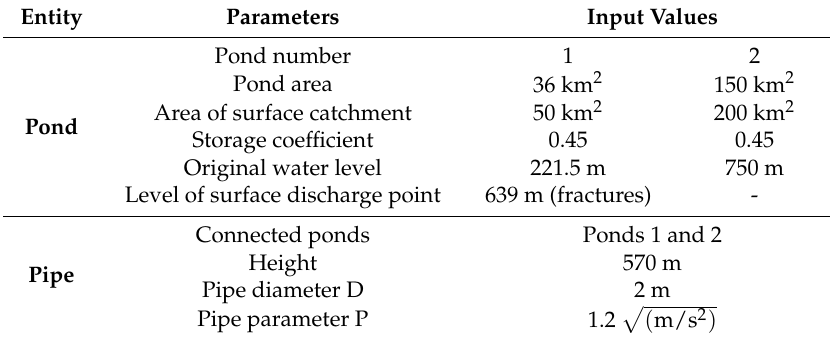
Values input into the SIMPL program for prediction of the Dongwon coal mine groundwater